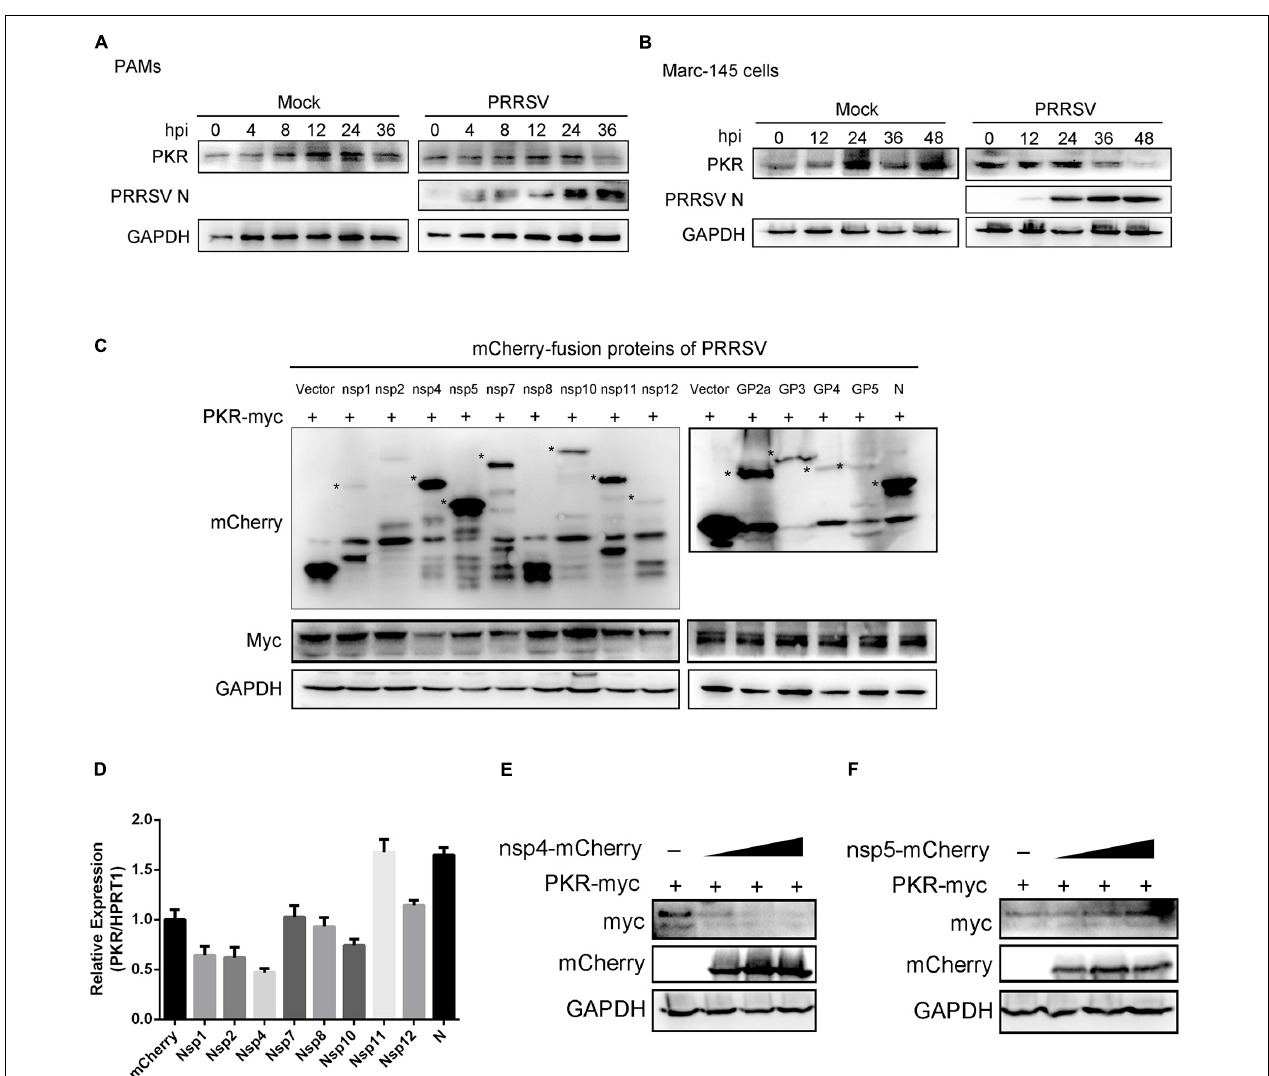
FIGURE 7 | PRRSV Nsp4 inhibits the expression of PKR protein. (A,B) PAMs (A) and Marc-145 cells (B) were mock-infected or infected with PRRSV (MOI = 1) for 0, 4, 8, 12, 24, and 36 hpi. The protein levels of PKR and PRRSV N were shown using Western blot analysis. (C) HEK293T cells were co-transfected with the plasmids expressing mCherry-tagged PRRSV proteins (1.5 µ g) and Myc-tagged PKR (1.5 µ g). Cells were harvested at 24 h post-transfection and subjected to Western blot analysis with anti-mCherry, anti-Myc, or anti-GAPDH antibodies. (D) PAMs were transfected with empty plasmid or the plasmids expressing PRRSV Nsp1, Nsp2, Nsp4, Nsp7, Nsp8, Nsp10, Nsp11, Nsp12, and N, respectively. qRT-PCR was used to detect the transcript levels of PKR. Data are normalized to HPRT1 in each sample. (E,F) The increased doses of mCherry-tagged PRRSV Nsp4 (E) or Nsp5 (F) plasmids and Myc-tagged PKR plasmid (1.5 µ g) were co-transfected